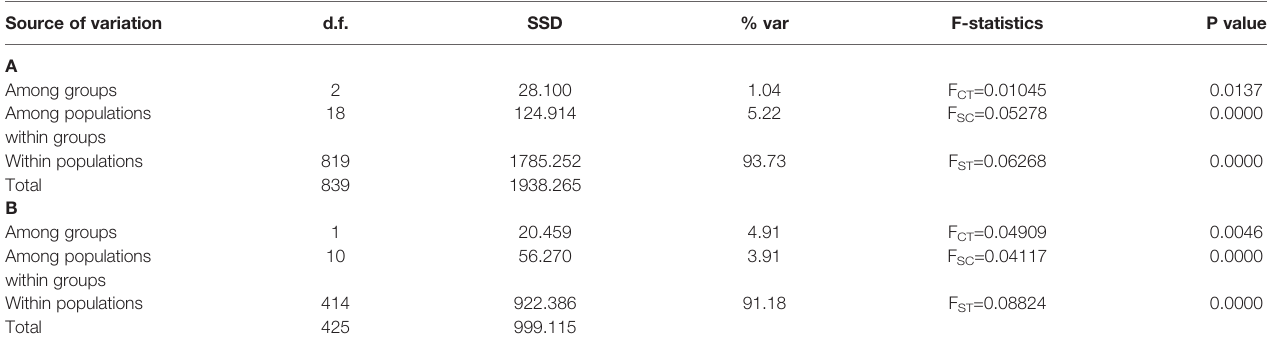
TABLE 3 | Hierarchical analyses of molecular variance (AMOVA) using nine microsatellite loci (after removing locus SLN35) and testing for two possible population